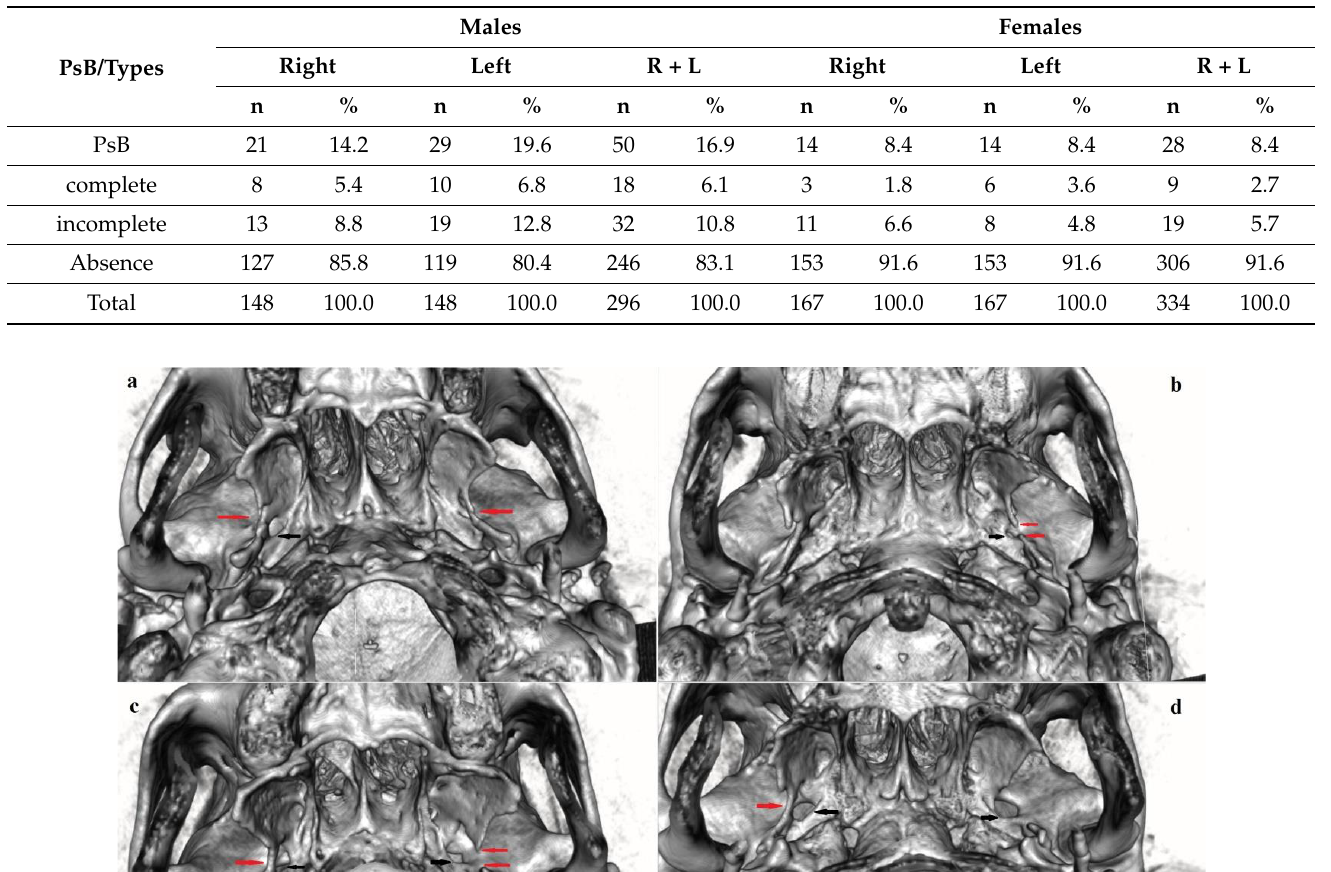
Table 2. Frequency of pterygospinous bridge in both sides and sexes.